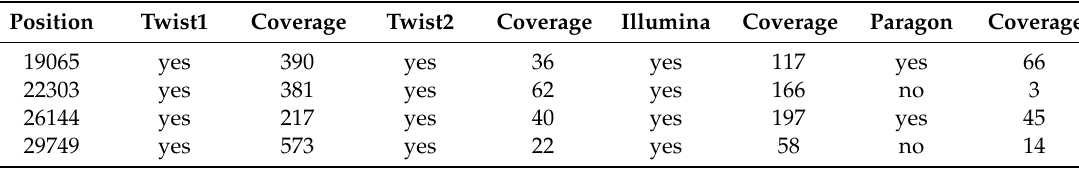
Table 1. Comparison of detected variant in synthetic control RNA. In our hands, the Paragon approach did not detect all four variants in generated data by standard reference mapping